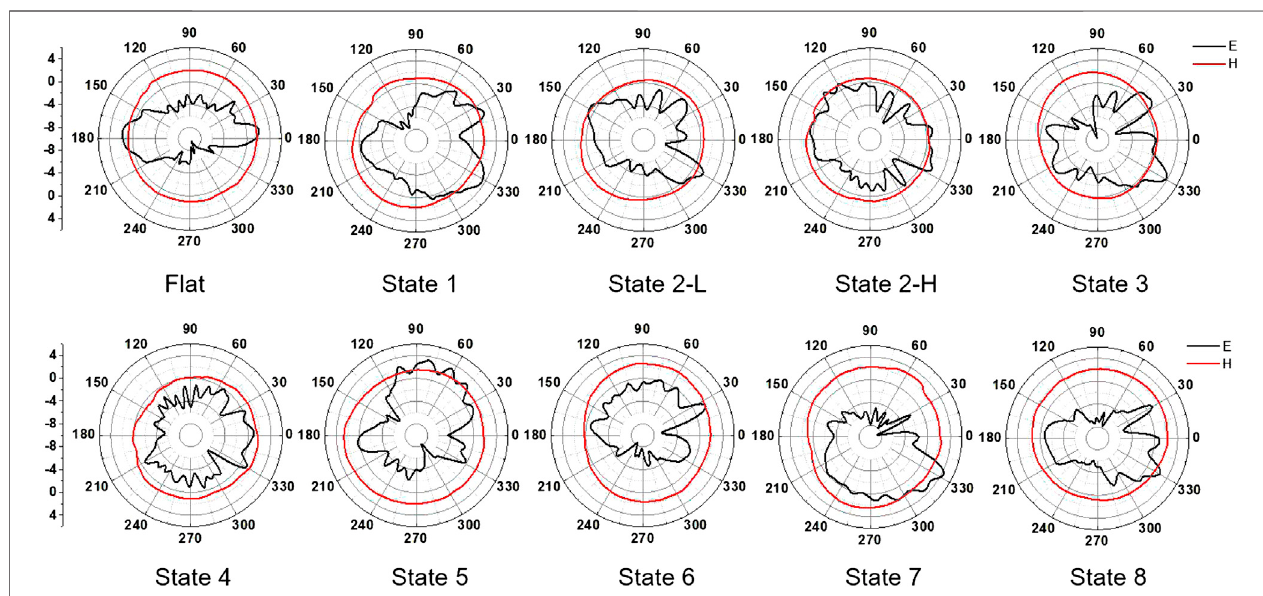
FIGURE11 | The radiation pattern test results ofhexagon-twist frequency recon fi gurable antenna with different stable state. Eand H denotes the radiation pattern cut plane with parallel electric fi eld direction and magnetic fi eld direction, respectively.